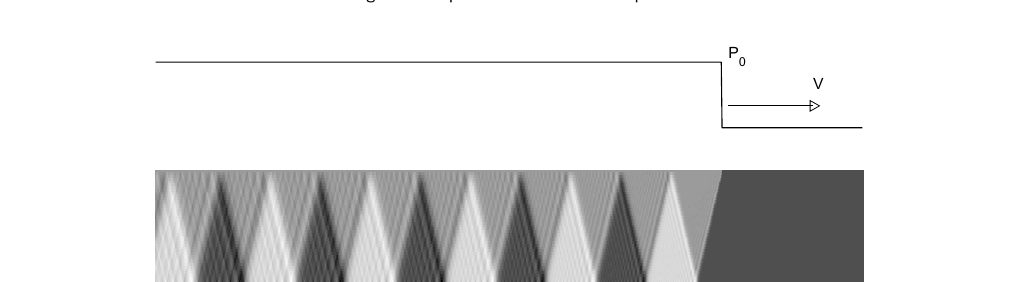
Fig. 8. Free pressure wave in the liquid.